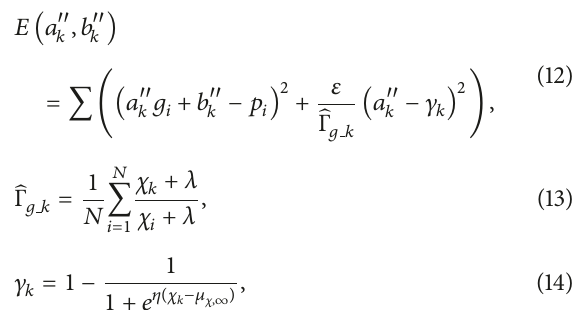
̂Γ Γ 𝑔 𝑘 and 𝑔 𝑘